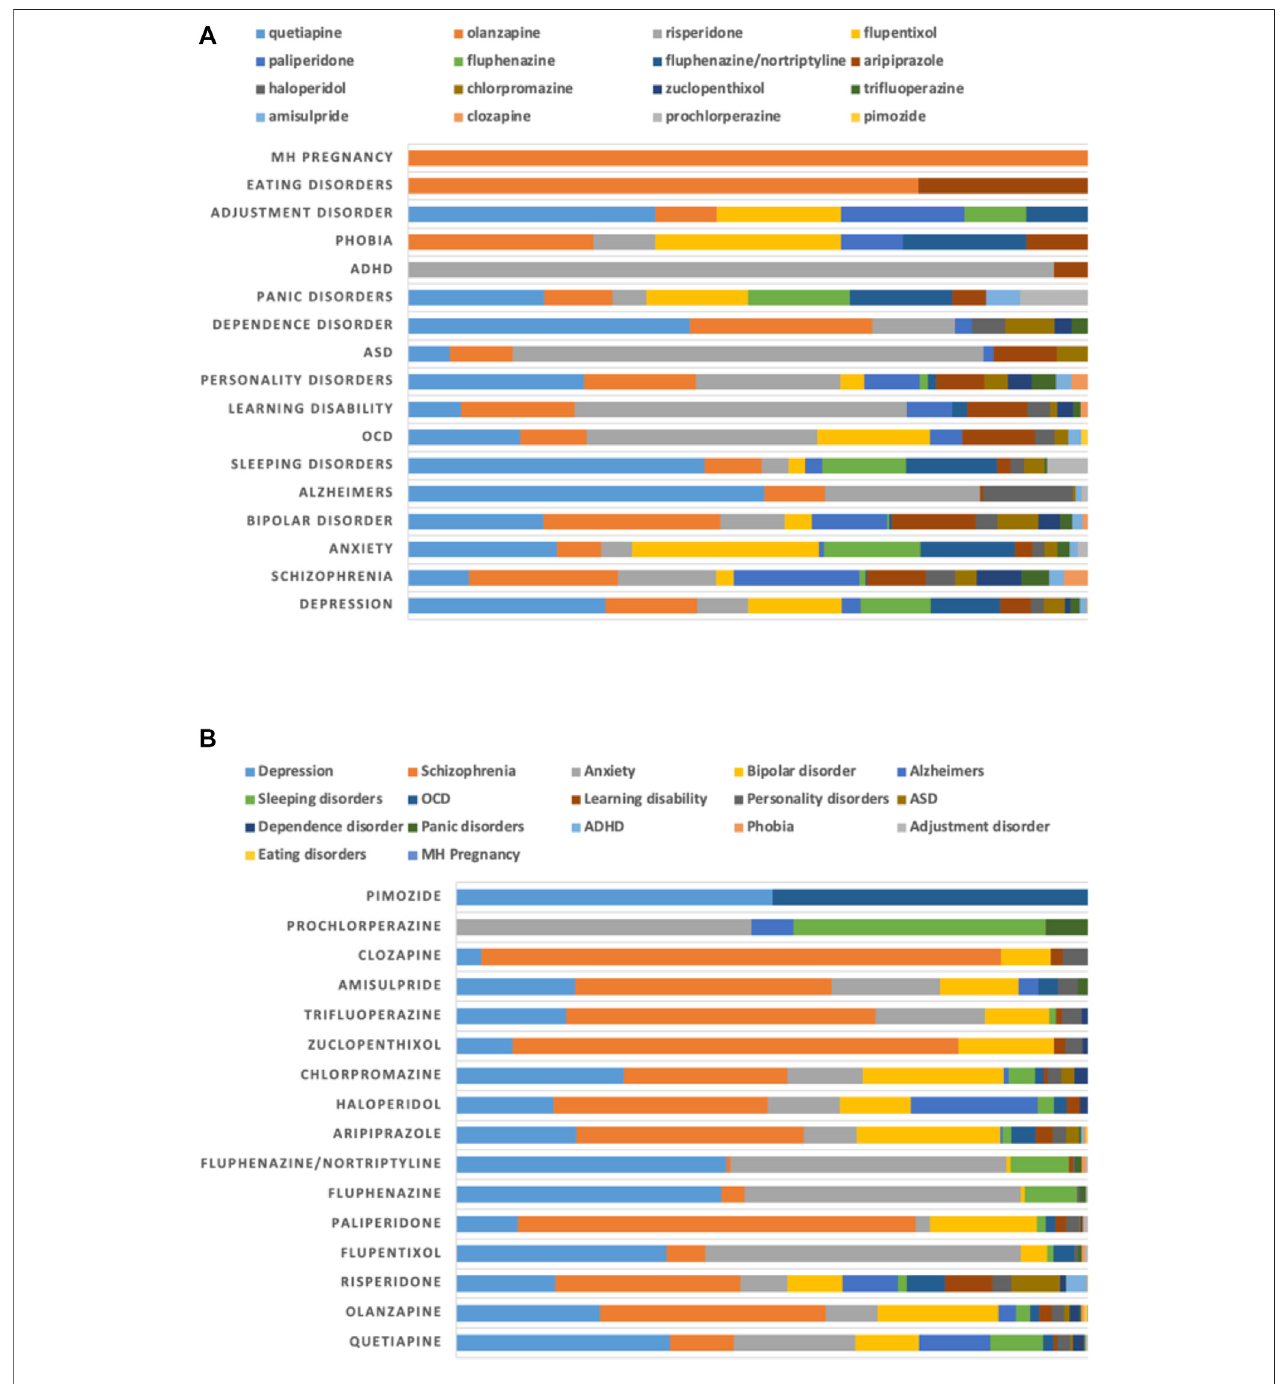
FIGURE 3 | Proportion of use of antipsychotics for mental health disorders (MHDs) strati fi ed by (A) diagnoses and (B) drugs.